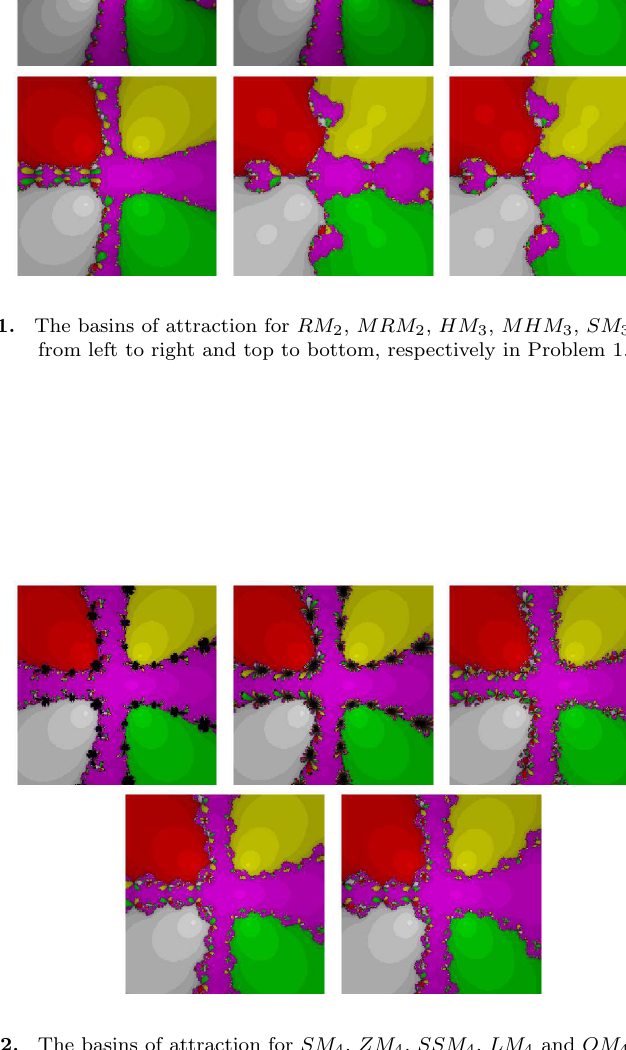
Figure 2. The basins of attraction for SM 4 , ZM 4 , SSM 4 , LM 4 and OM 4 , from left to right and top to bottom, respectively in Problem